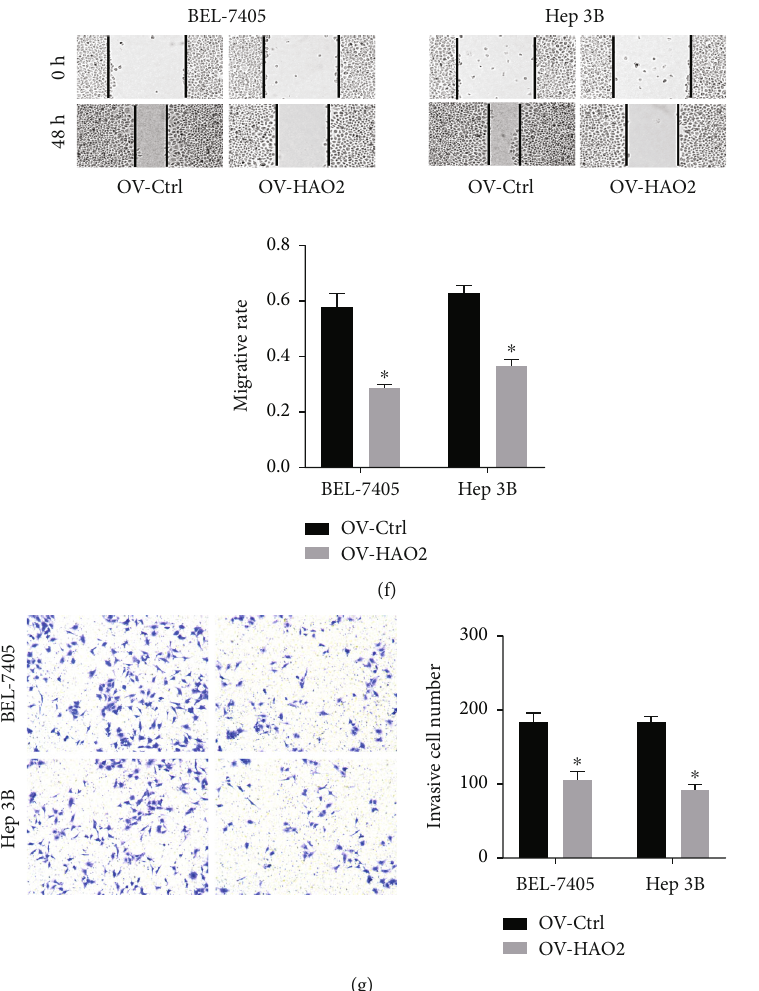
Figure 2: HAO2 overexpression inhibits HCC cell proliferation, migration, and invasion. (a and b) The e ffi ciency of HAO2 overexpression was determined by qRT-PCR and western blot analysis. (c, d, and e) Determination of cell proliferation by the CCK-8 assay, colony formation assay, and Edu incorporation assay. (f and g) Cell migration and invasion ability were measured by wound healing assay and Transwell assays. ∗ P < 0 : 05 , ∗∗∗ P < 0 : 001